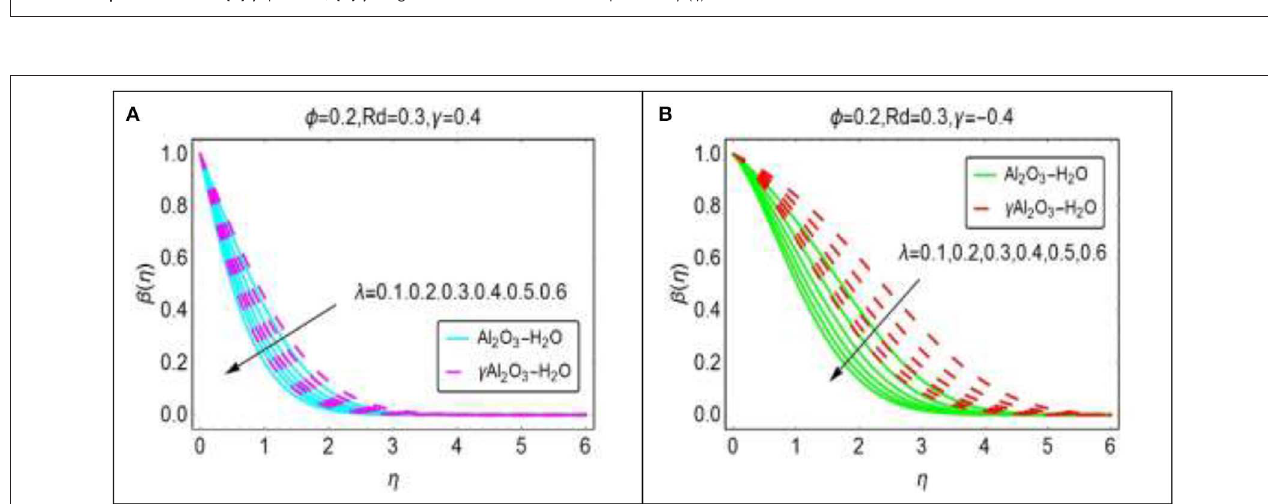
FIGURE 7 | The effects of λ on dimensionless temperature β ( η ) for (A) γ = 0.4, (B) γ = − 0.4.